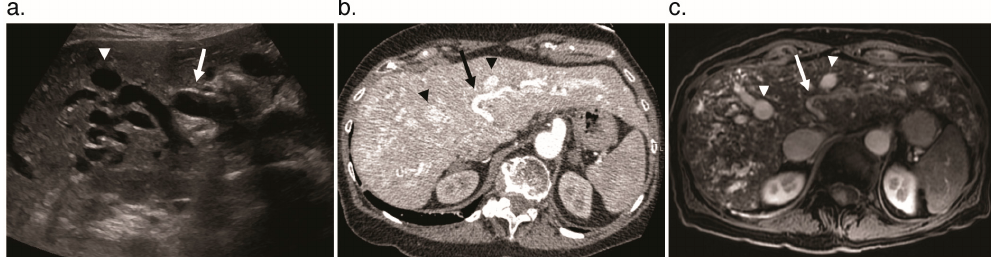
Figure 5. Correlative US, CT, and MR imaging in a 69-year-old woman with HHT. ( a ) Longitudinal grayscale US, ( b ) axial CT angiogram, and ( c ) axial T 1 fat-saturated gadolinium-enhanced arterial phase images show dilation of the hepatic artery (arrow) and hepatic veins (arrowheads) in this patient with multiple arteriosystemic shunts.